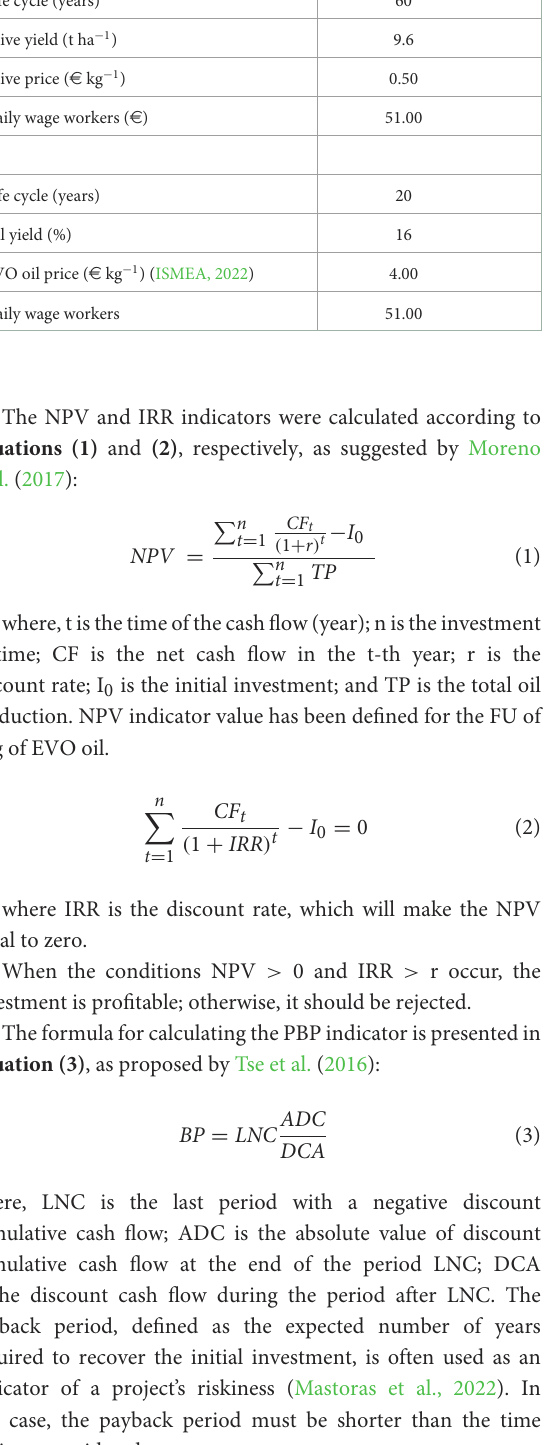
TABLE 2 Main technical and economic parameters adopted in the study for both scenarios. Agricultural